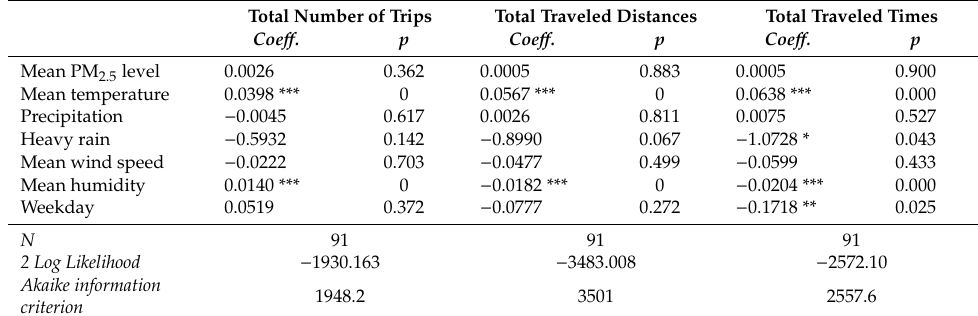
Table 10. Estimation results for bike sharing use using PM 2.5 level data in fall.